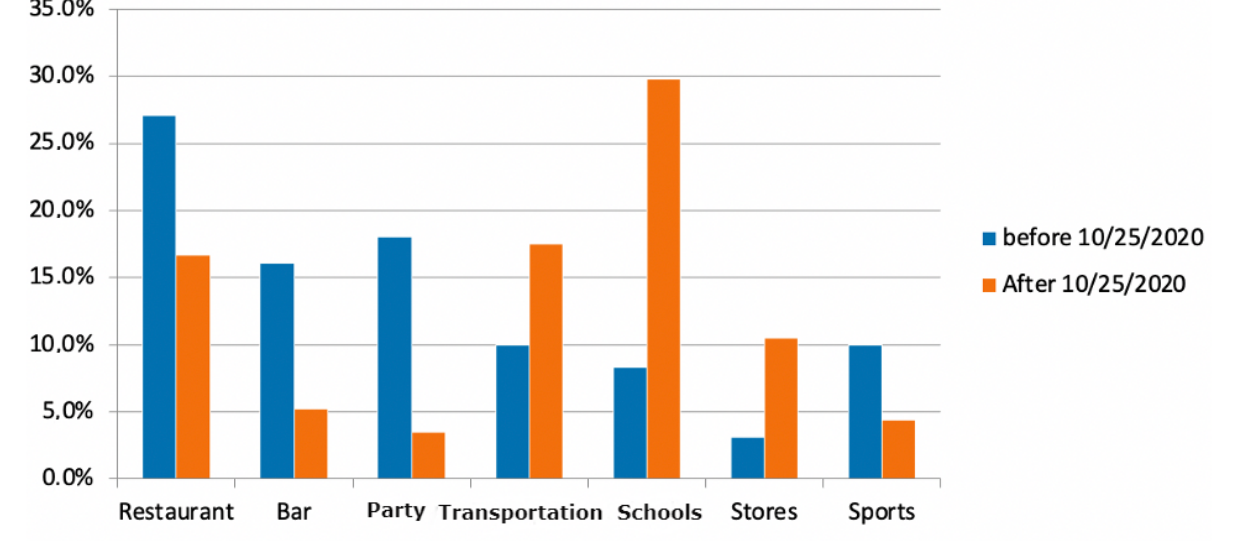
Figure 5. Main collective places concerned by contaminations before and after lockdown ( P <.001); only principal location of collective